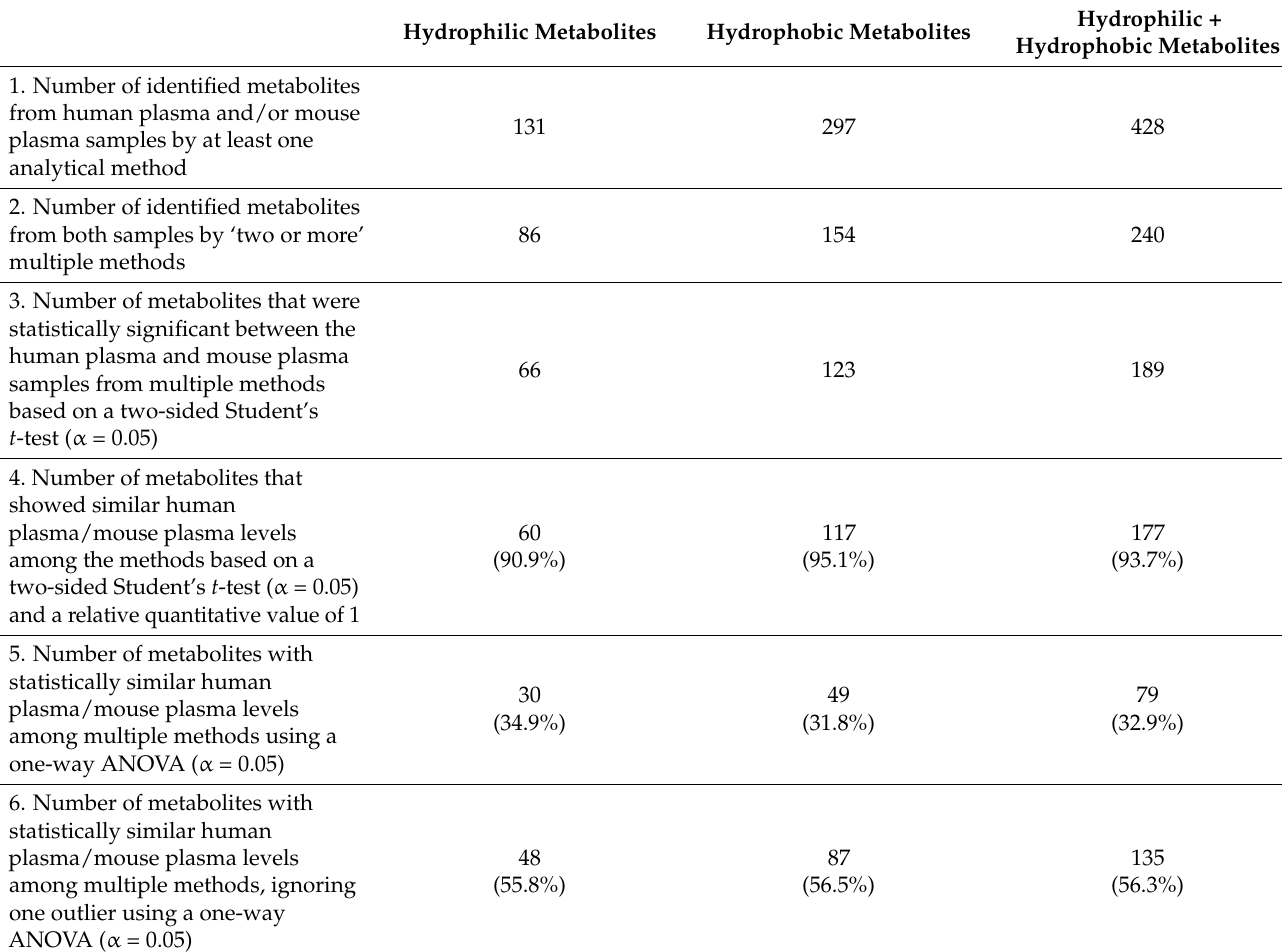
Table 4. Summary of the datasets after the selection of the quantitatively guaranteed metabolites. Hydrophilic